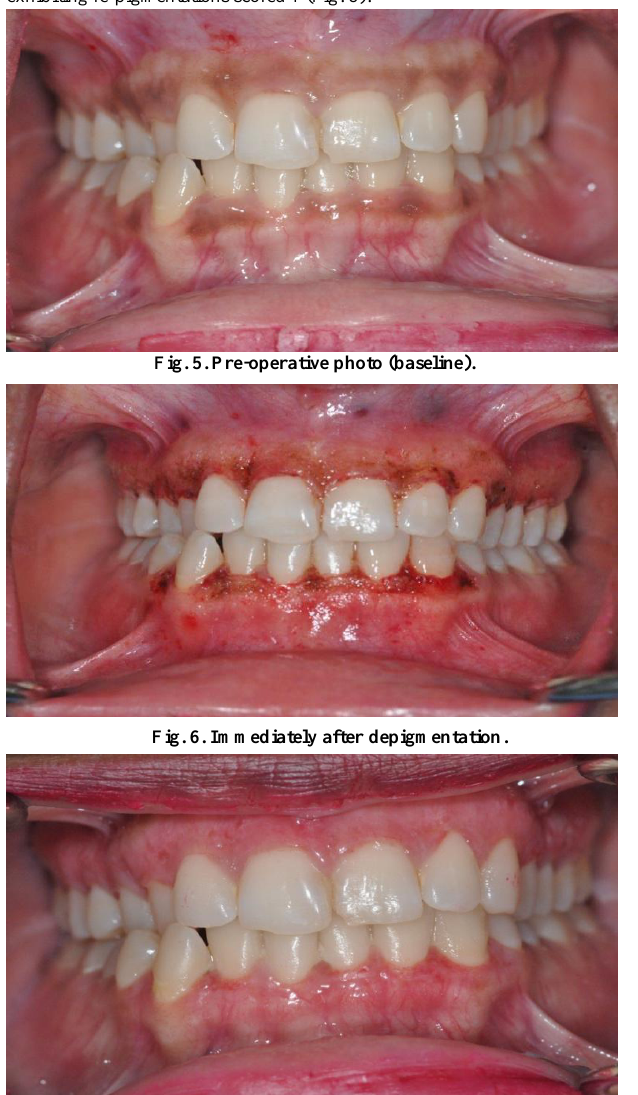
Fig. 7. One-week follow-up.